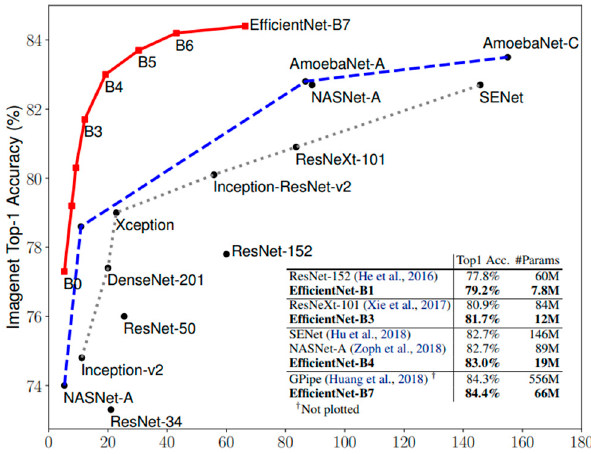
Figure 5. Comparison among EfficientNet and other popular CNN models in terms of ImageNet accuracy vs. model size [53].